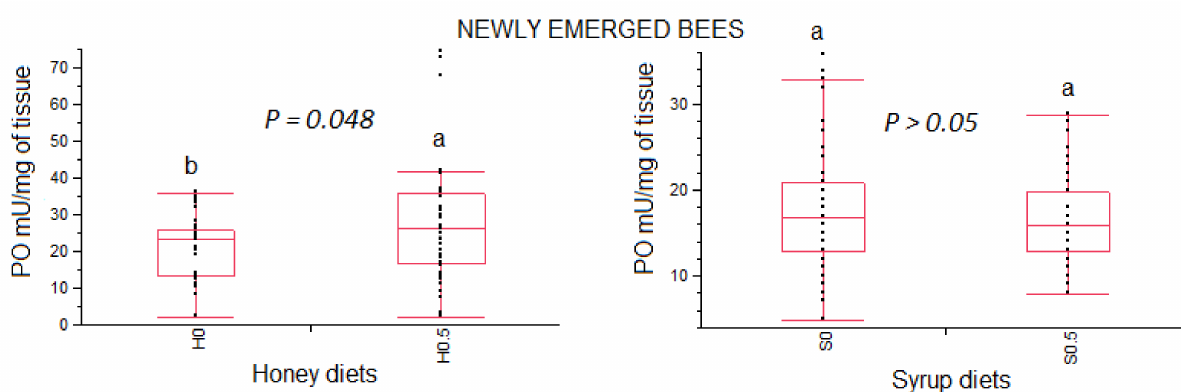
Figure 3. Box plots of the phenoloxidase activity (PO) in newly emerged bees fed different base-diets (honey and syrup) with added β -glucans (0.5% w / w ). Data are presented as medians and range (min and max values). Different lowercase letters above the bars indicate statistical differences between honey or syrup diets according to the non-parametric Wilcoxon test. H = honey; S = syrup; 0, 0.5 = % ( w / w ) 1,3-1,6 β -glucans.